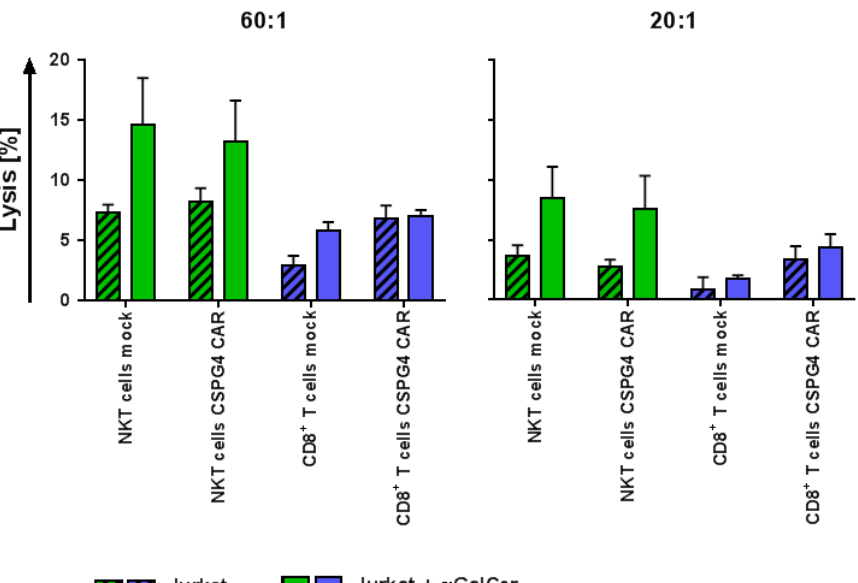
Figure 5. The CSPG4 CAR- transfected NKT cells maintain their intrinsic cytotoxicity against α